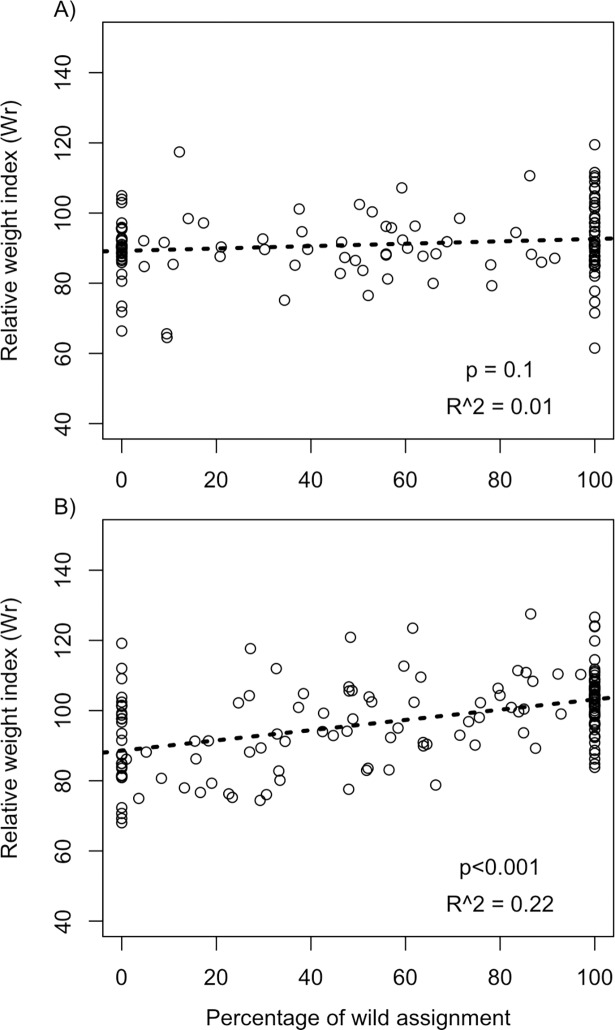
Relative weight condition index (Wr) as a function of percentage of local assignment for (A) piscivorous and (B) planktivorous populations.